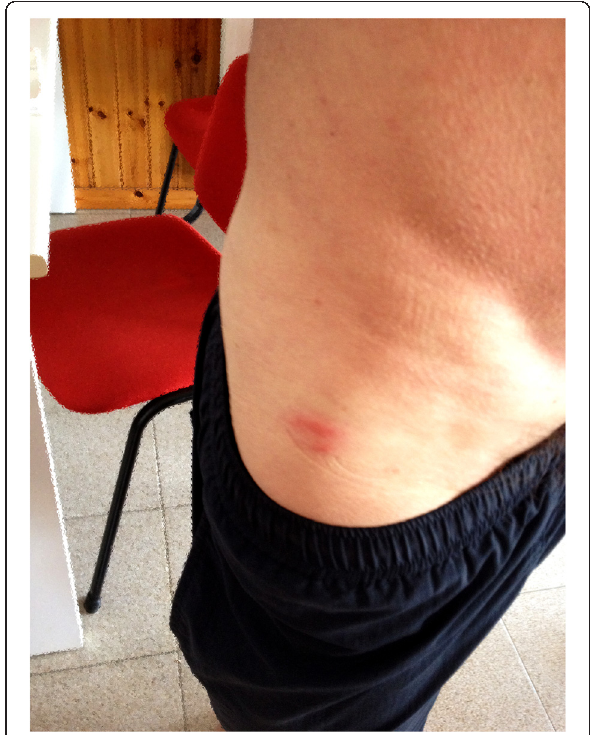
Figure 3 Raised red itchy rash on the skin of the right thigh of a 40-year-old man stung by Sclerodermus